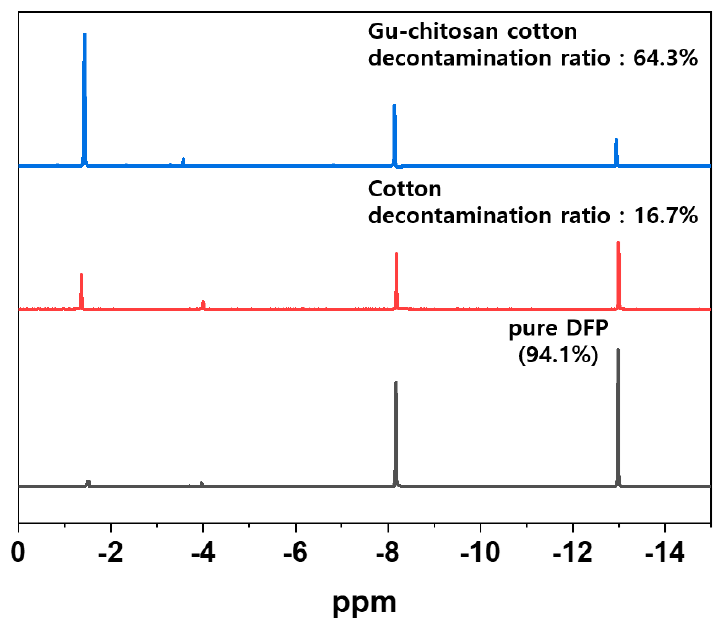
Figure 11. 31 P-NMR spectra of the pure DFP and the extracted DFP and DHP solutions from the untreated and Gu-chitosan-treated cotton fabrics after the decontamination experiments.